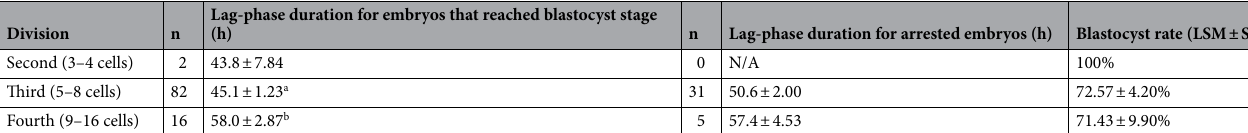
Table 3. Duration of the lag-phase and blastocyst development rates for embryos displaying a lag-phase after the second, third or fourth division. n = number of embryos that displayed lag-phase in each category. Different superscripts (a and b) characterize statistical differences ( p < 0.05). Results are stated as least square means ± standard errors.